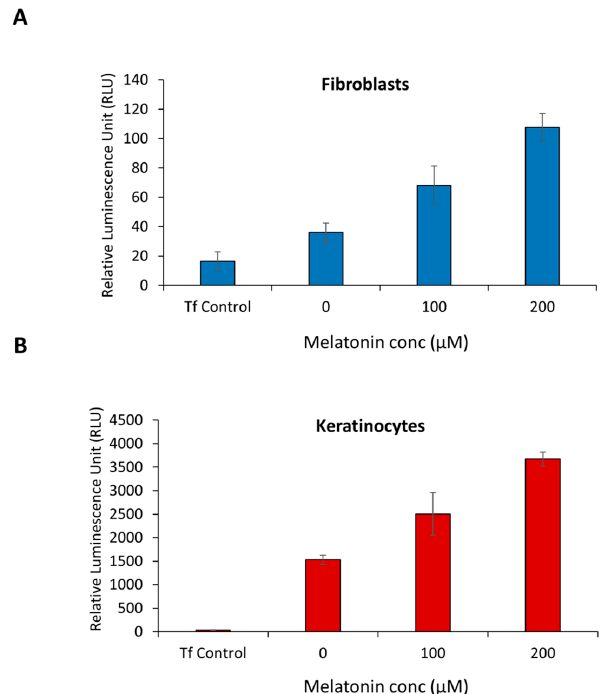
Figure 1. PER1 expression increases in response to higher concentration of melatonin. ( A ) Normal Human Dermal Fibroblasts (NHDF) and ( B ) Normal Human Epidermal Keratinocytes (NHEK) were incubated with di ff erent concentration of melatonin for 24 h, and the level of expression of PER1 was evaluated using a reporter gene assay. Tf Control, transfection control. Error bars are SEM. N =